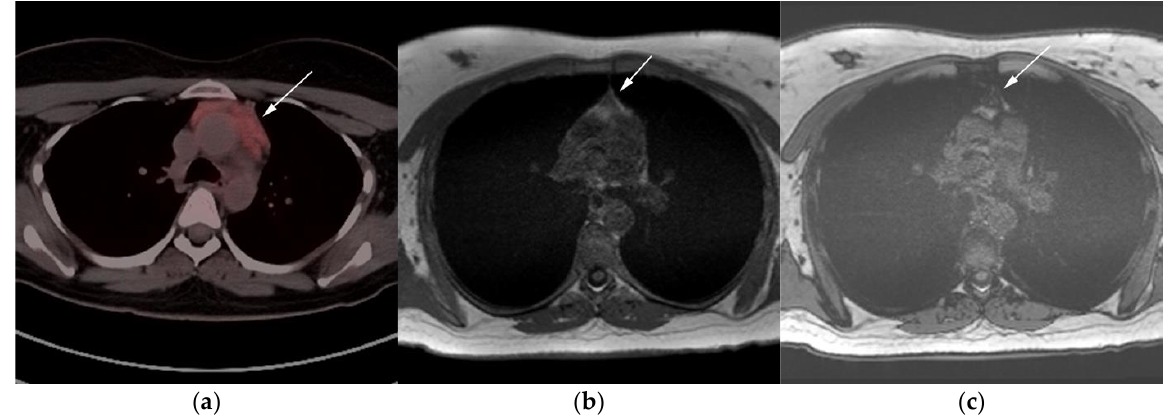
Figure 7. Imaging in a 20-year-old female with history of classic Hodgkin’s lymphoma (CHL) who had 4 cycles of chemotherapy. ( a ) Axial 18F-FDG PET/CT showing residual wedge-shaped/triangular activity seen within the anterior mediastinum (arrow). There was concern for residual disease vs. thymic rebound hyperplasia. ( b ) MRI axial T1 in phase and ( c ) MRI axial T1 out of phase show intermedial signal on T1 in phase (arrow) with dropped signal on the out of phase sequence (arrow), consistent with fat content due to thymic rebound hyperplasia.